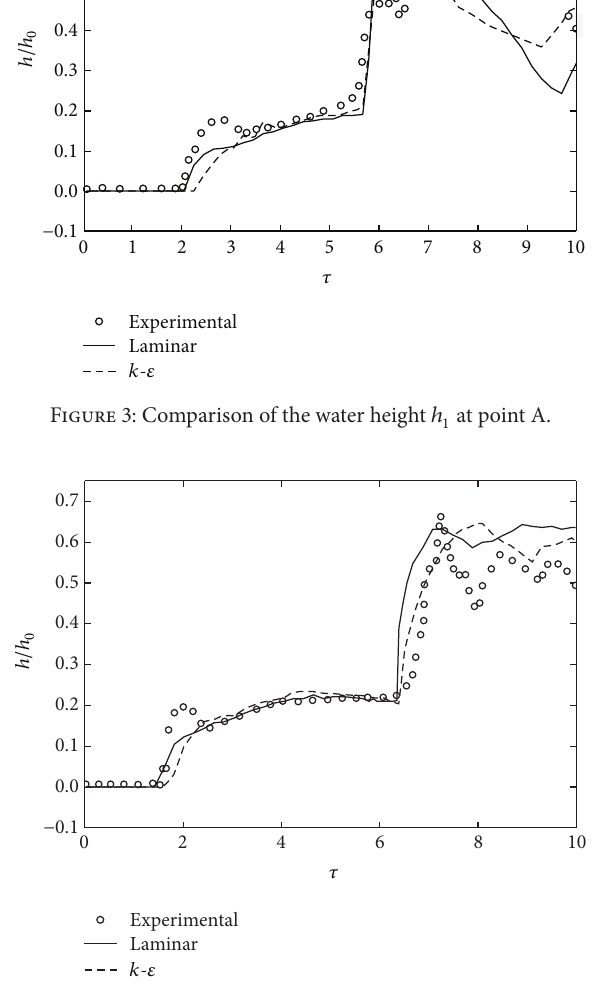
Figure 4: Comparison of the water height ℎ 2 at point B.